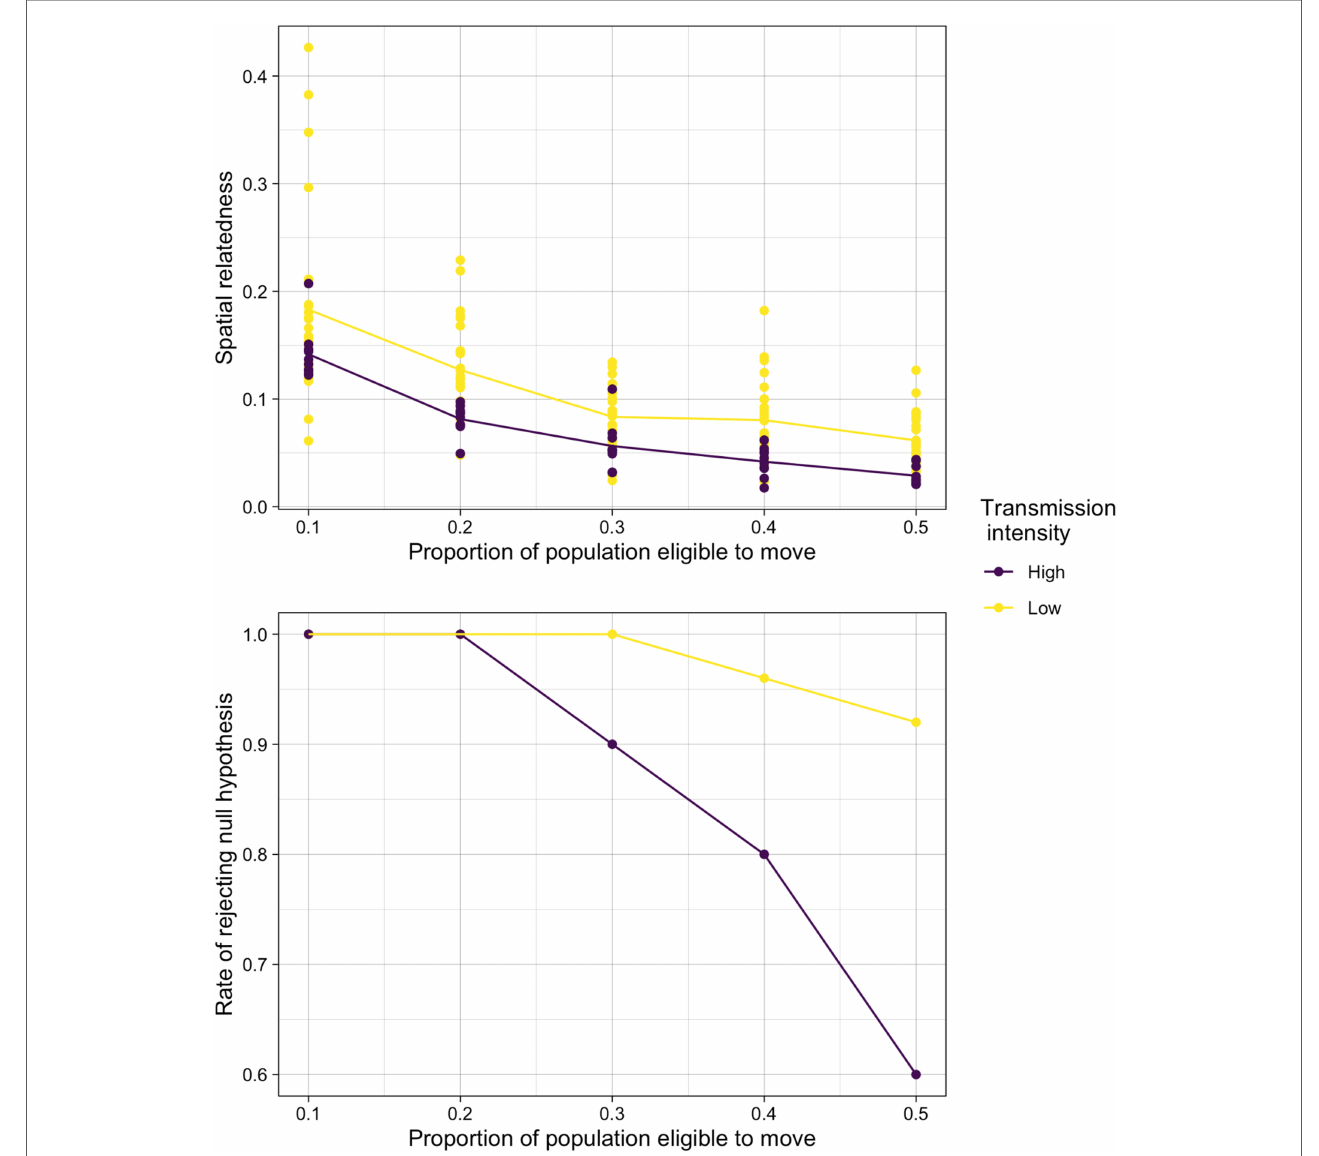
FIGURE 4 The comparison of relatedness results in simulated high and low transmission settings. ( A ) Spatial relatedness (averaged across both locations) and ( B ) rate of rejecting the null hypothesis under normal sampling in the high and low transmission intensity